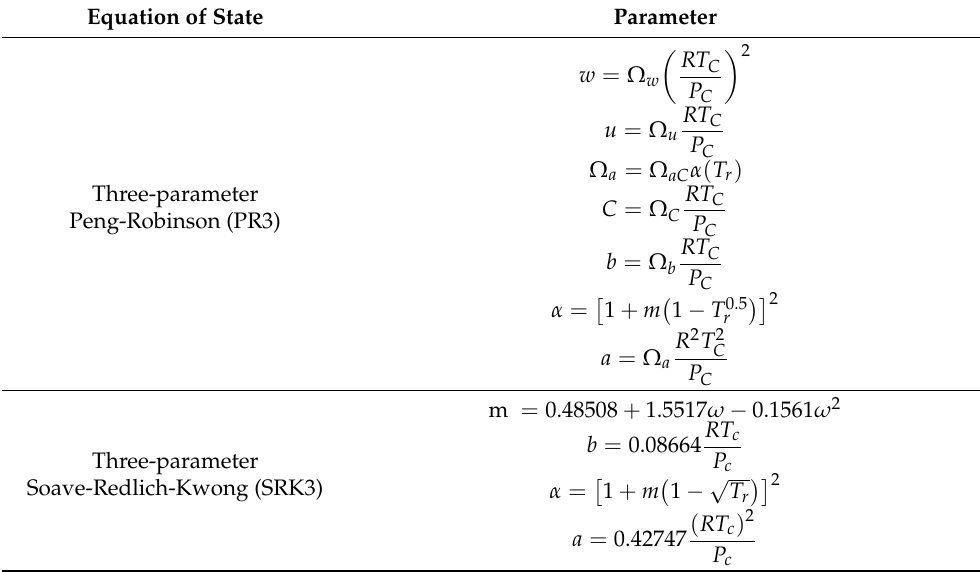
Table 6. Cont. Equation of State